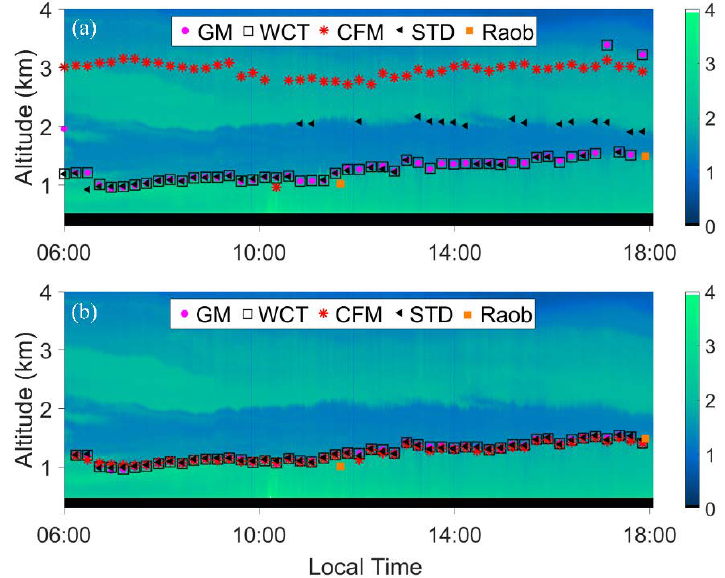
Figure 9. Evolution of the PBL at double layer aerosol conditions observed with backscatter lidar (range-corrected 532 nm signal, 30 s, 7.5 m resolution) on 23 August 2017. ( a ) PBLH determined directly from four lidar methods without restriction. ( b ) PBLH determined from the four lidar methods after initializing MLH and setting RR.